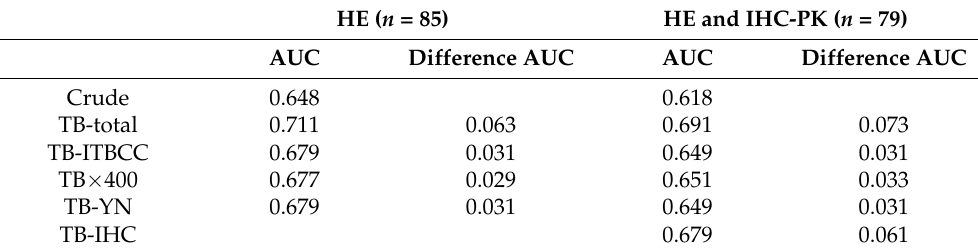
Table 4. Performance of two methods of assessing TB based on HE and pancytokeratin IHC. HE ( n = 85) HE and IHC-PK ( n = 79) AUC Difference AUC AUC